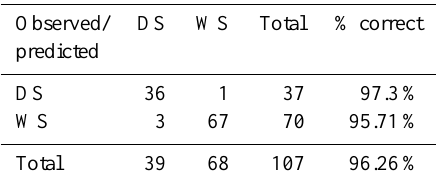
Table 3. Results of the discriminant analysis based on major ele- ments and carried out on samplings DS and WS.